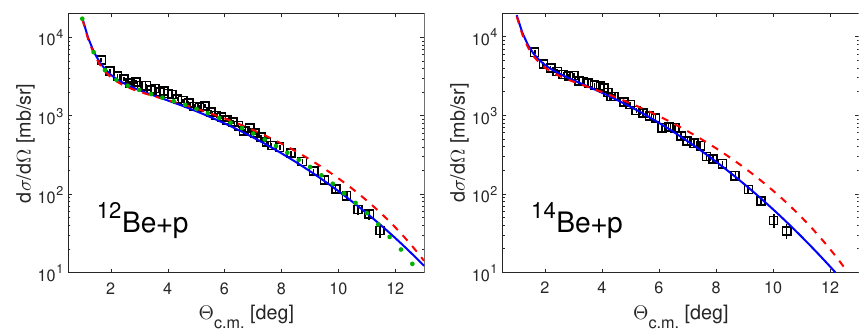
Figure 3. Comparison with experimental data of the calculated cross sections when using the SF (blue solid), VMC (green dotted) and GCM (red dashed) nuclear density distributions. The left side is for 12 Be + p at 703.5 MeV, and the right one is for 14 Be + p at 702.9